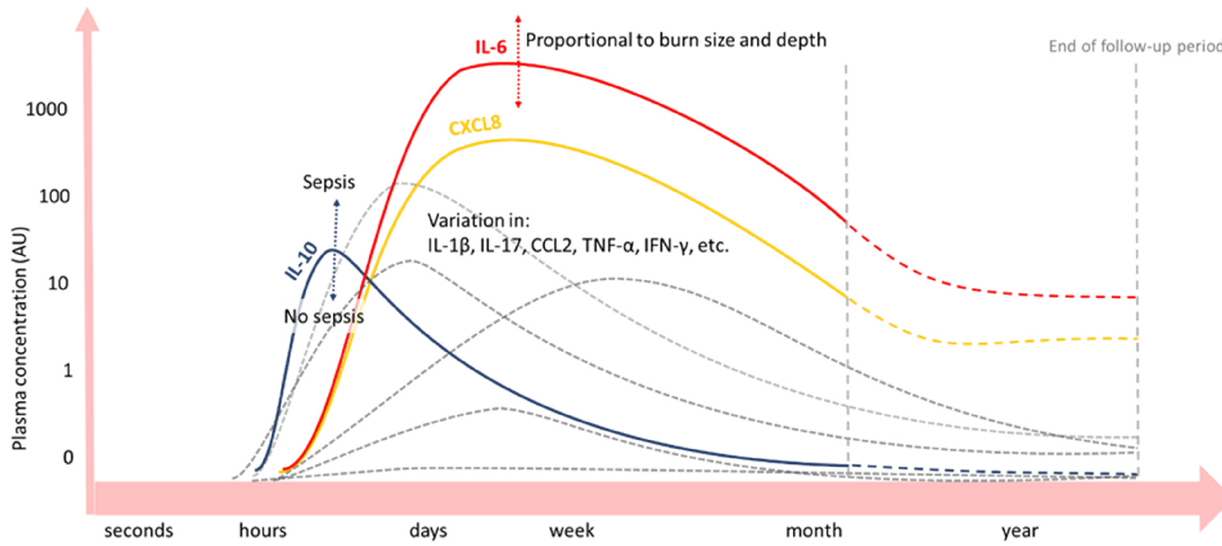
Figure 3. Blood concentrations of cytokines and growth factors after severe burn injury [29–36]. Inflammatory cytokines IL-6 (red) and CXCL8 (yellow) are significantly increased up to a month or even years (dashed lines) post-burn. IL-10 (blue) peaks on day one post-burn and declines hereafter. Peak concentrations of IL-6 and IL-10 depend on burn wound size and depth and presence of sepsis, respectively. Plasma concentrations over time of other inflammatory mediators vary among burn patient follow-up studies (grey lines).